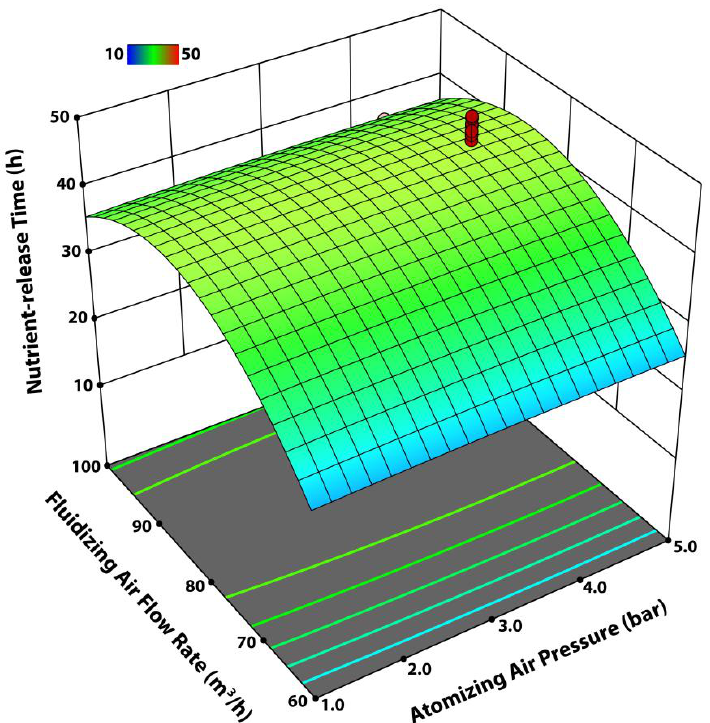
Figure 12. Interactive effect of the fluidizing air flow rate ( Q air ) and atomizing air pressure ( P air ) on the nutrient-release time.